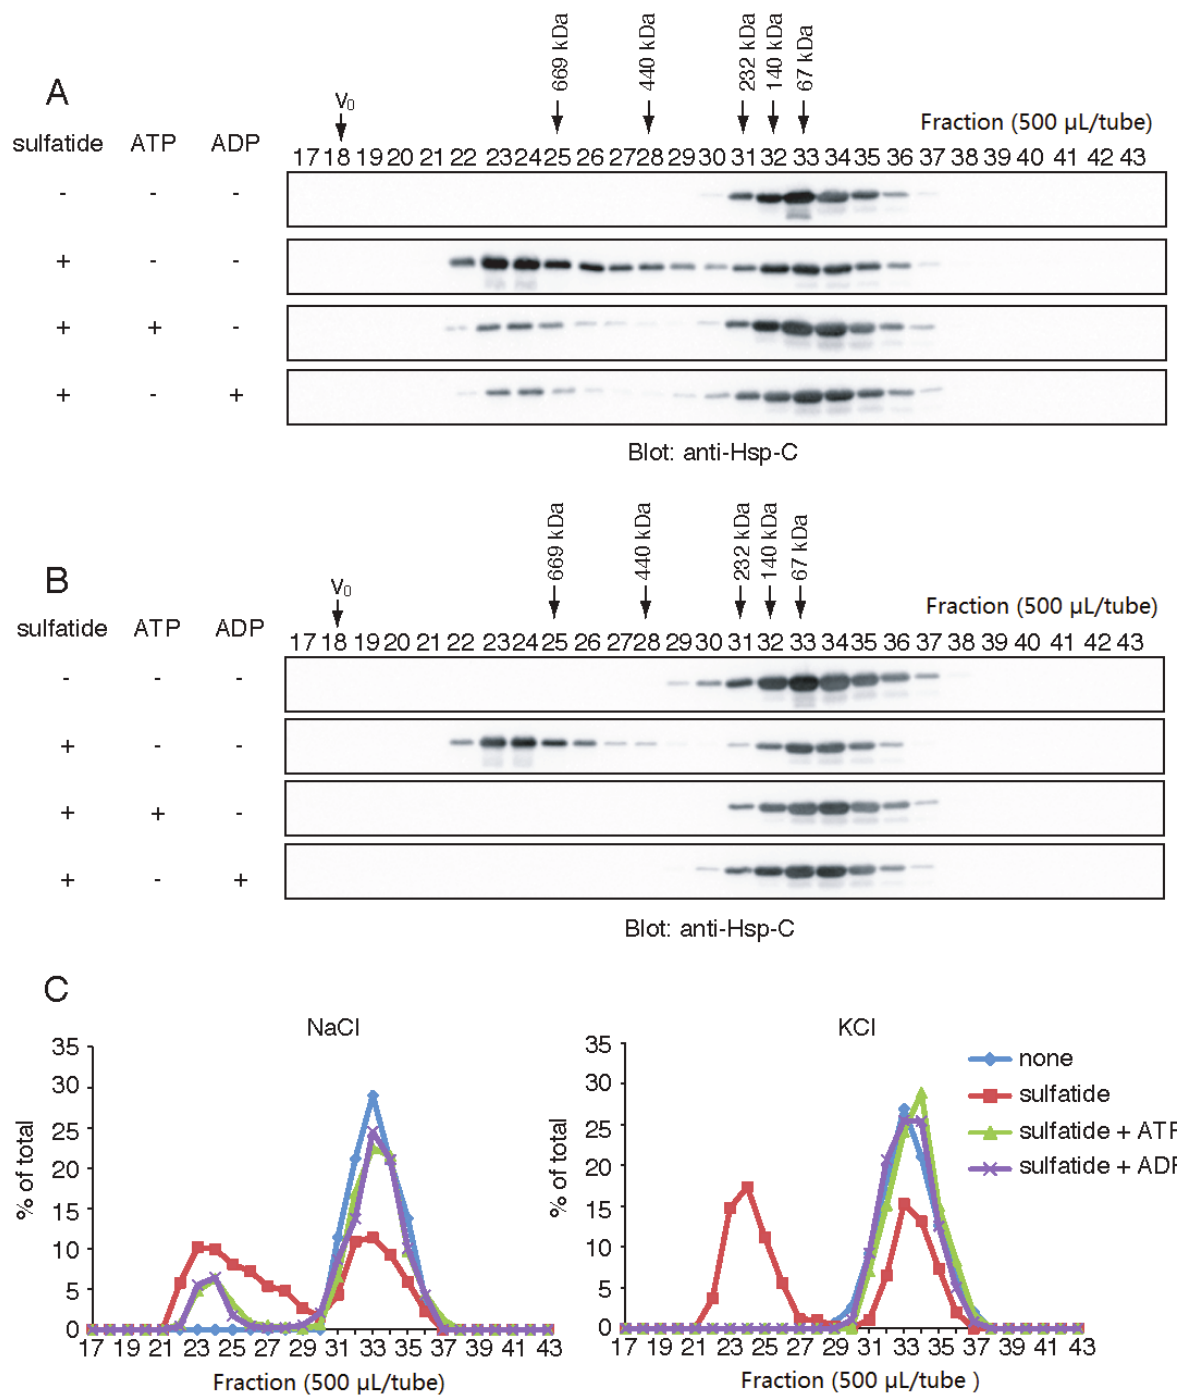
Figure 3. ATP and ADP inhibits the sulfatide-induced formation of the high molecular-weight (HMW) Hsp70. Wild-type Hsp70 was incubated with (+) or without ((cid:5)) sulfatide, ATP and ADP in a buffer containing either 150 mM NaCl ( A ) or KCl ( B ), and separated by gel-filtration chromatography under the same salt conditions. Fractions (500 (cid:2)L) were precipitated with trichloroacetic acid (TCA) and analyzed by Western blot using anti-Hsp-C antibody. V 0 indicates void volume. Thyroglobulin (669 kDa), Ferritin (440 kDa), catalase (232 kDa), aldolase (140 kDa) and albumin (67 kDa) were used as molecular weight markers; ( C ) Quantification of B . Total intensity of Hsp70 was set to